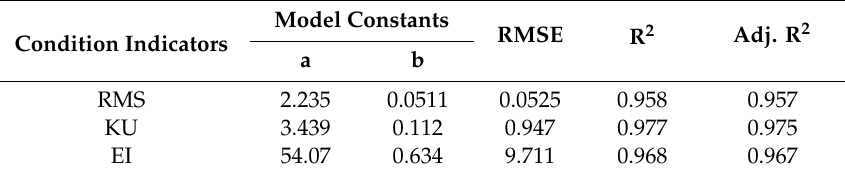
Table 2. General optimal estimated exponential model constants.